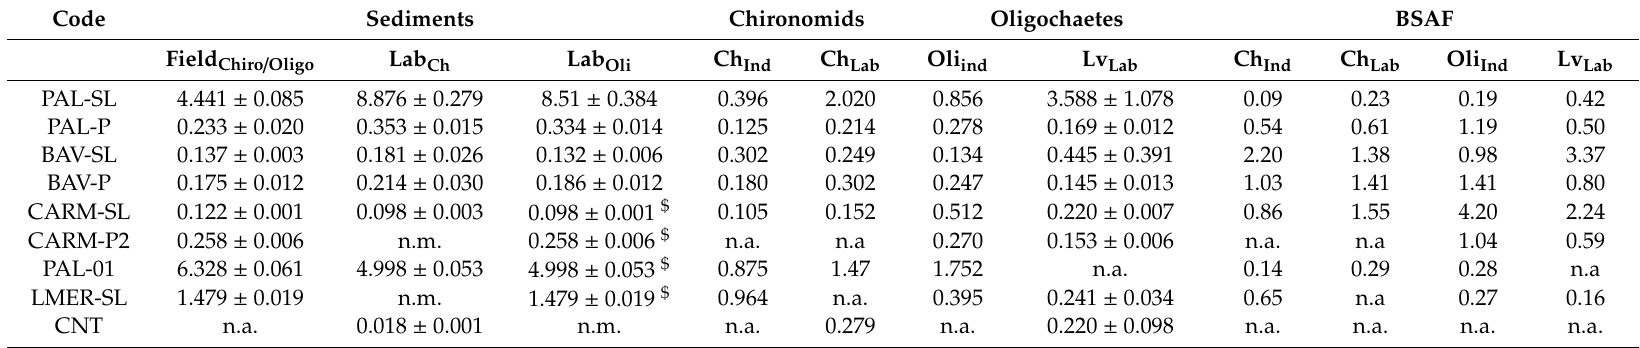
— — — — — — — — — — — — — — — Table 2. Total mercury concentrations (mg kg − 1 dry weight) in sediments, and indigenous and laboratory-exposed organisms. Field Chiro / Oligo : sediment aliquots for indigenous Hg analysis; Lab Ch and Lab Oli : sediment aliquots used for bioaccumulation tests on Chironomus riparius and Lumbriculus variegatus ; Ch Ind and Oli Ind : indigenous chironomids and oligochaetes; Ch Lab and Lv Lab : C. riparius and L. variegatus exposed to tests; BSAF: biota-sediment accumulation factor; CNT: control exposures; n.a.: not applicable; n.m.: not measured. Concentrations with $ were not measured and values from other aliquots were considered for calculation and comparison